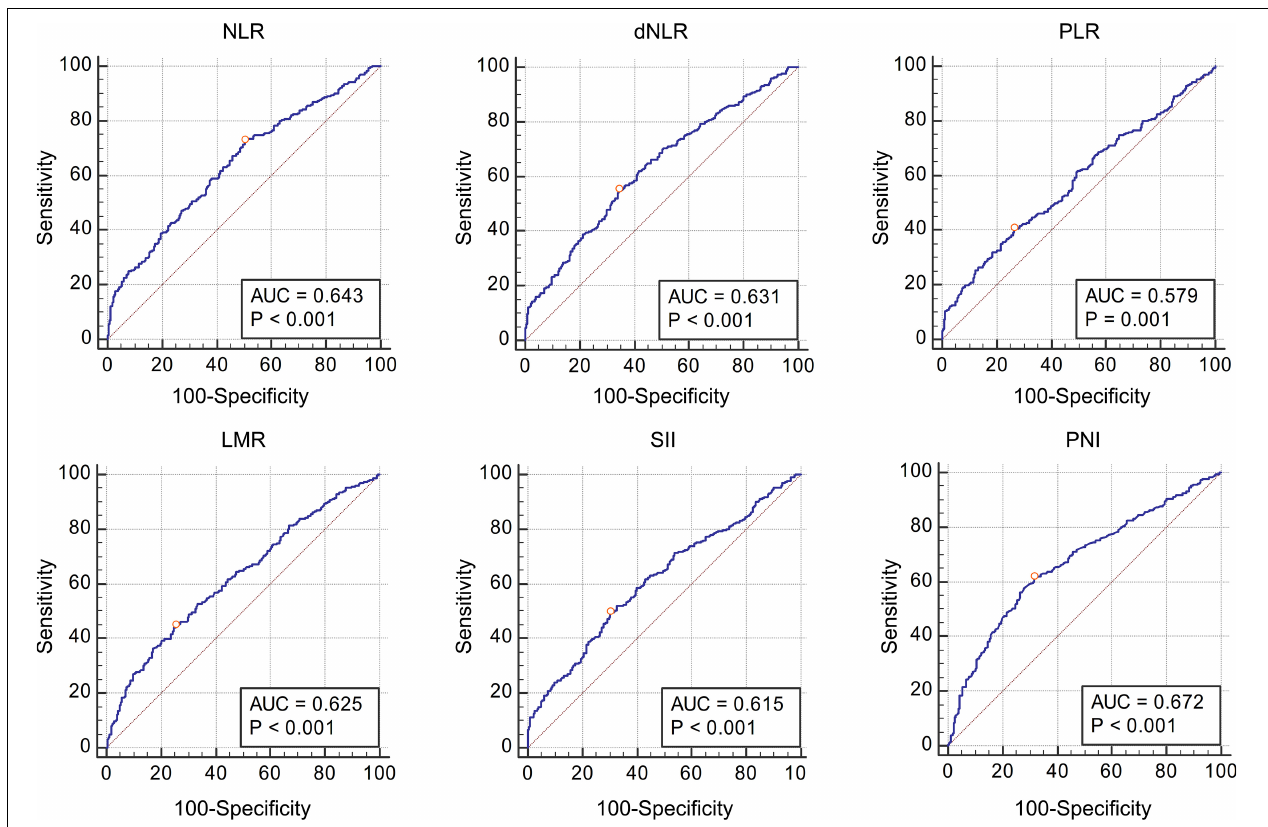
FIGURE 1 | The Receiver Operating Characteristic curves and Area Under Curve of NLR, dNLR, PLR, LMR, SII, and PNI for pathological grade. All these inflammatory factors had predictive value for pathological grade ( P < 0.001, P < 0.001, P < 0.001, P < 0.001, P < 0.001 and P < 0.001 respectively), and the optimal cut-off values were 4.24, 4.23, 190.44, 2.11, 1337.80, and 51.70,